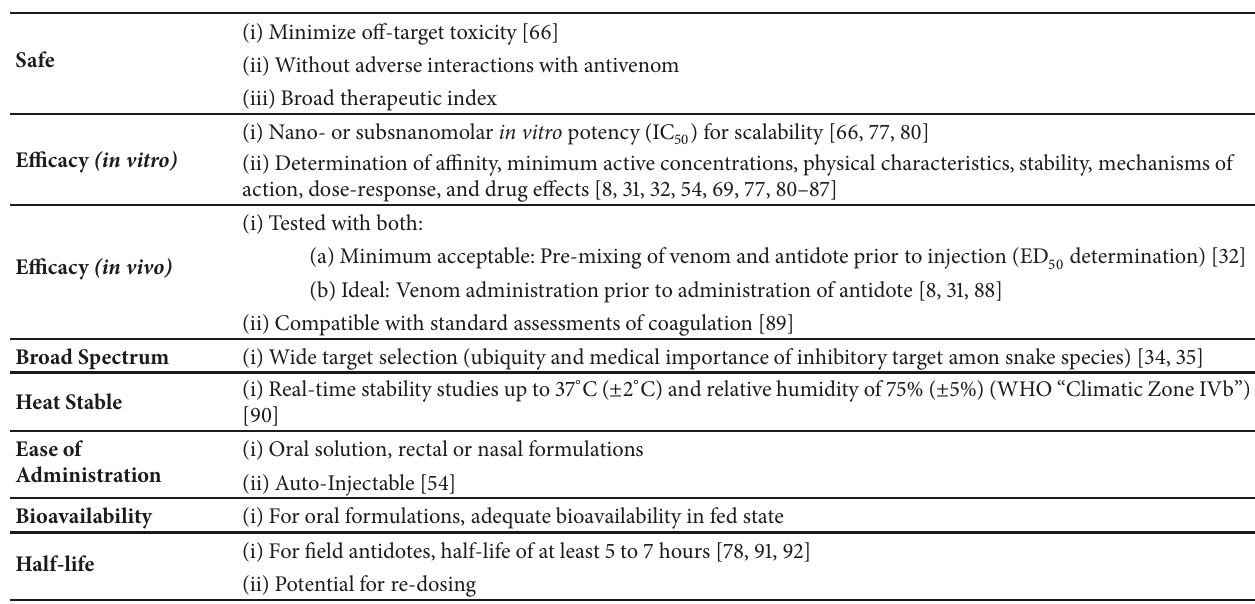
Table 1: Desirable preclinical characteristics of an SMT for snakebite.